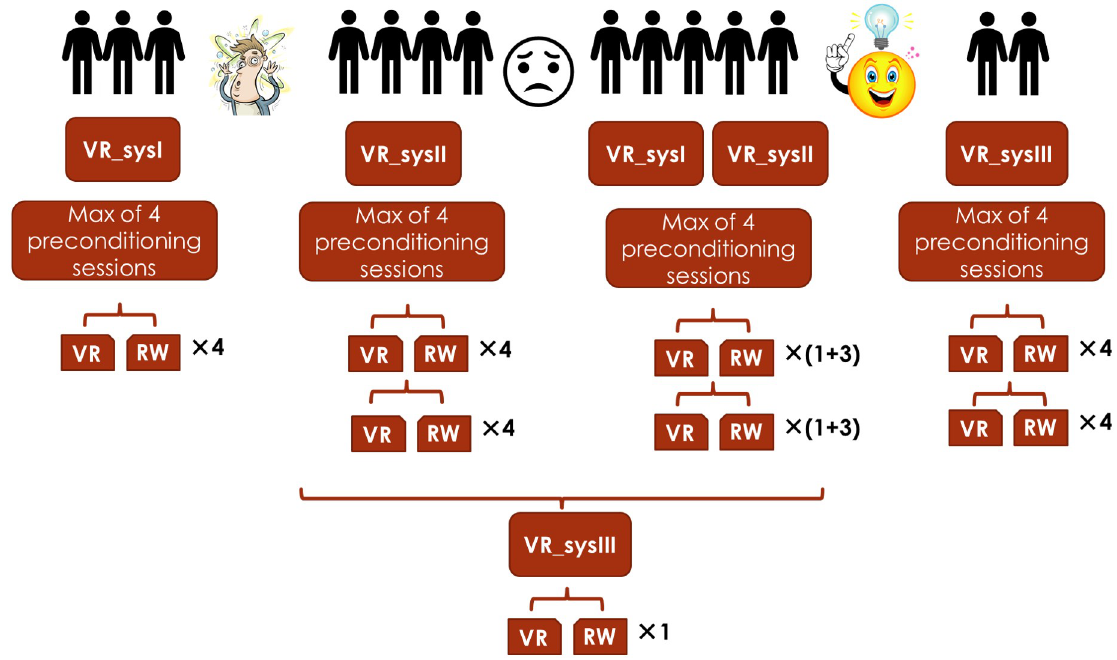
Fig 3. Summary of the experiments. Experiments started on the left side and proceeded to the right